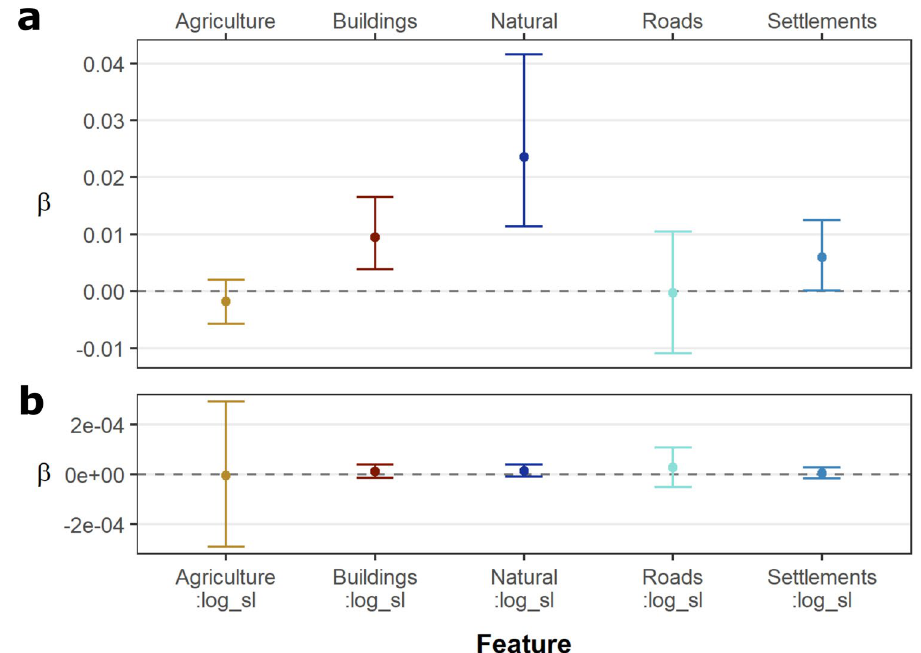
Figure 4. Population level ISSF model results based on distance to habitat features. ( a ) Point estimates and 95% confidence intervals for habitat selection. Positive estimates suggest association with the habitat feature. ( b ) Estimates for the influence of distance to habitat features on step lengths. This figure was created using R v.4.0.5 (https://r- proje ct. org/) in RStudio v.1.4.1106 (https:// rstud io.